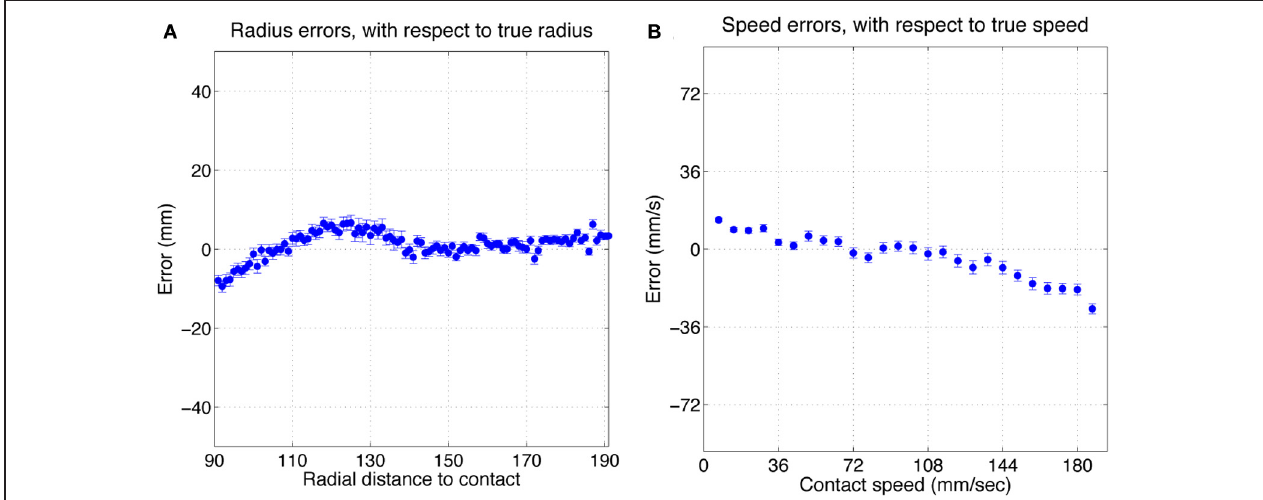
FIGURE 6 | Mean classification error for radial distance error, with respect to true radial distance (A), and for contact speed, with respect to true contact speed (B). Errorbars show standard error.